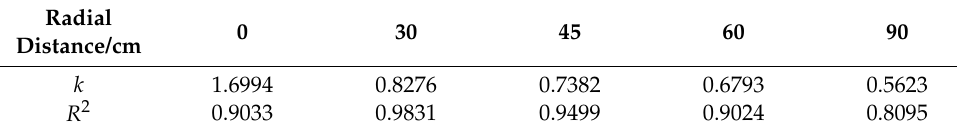
Table 5. Adjustment coefficients for deflections at each radial